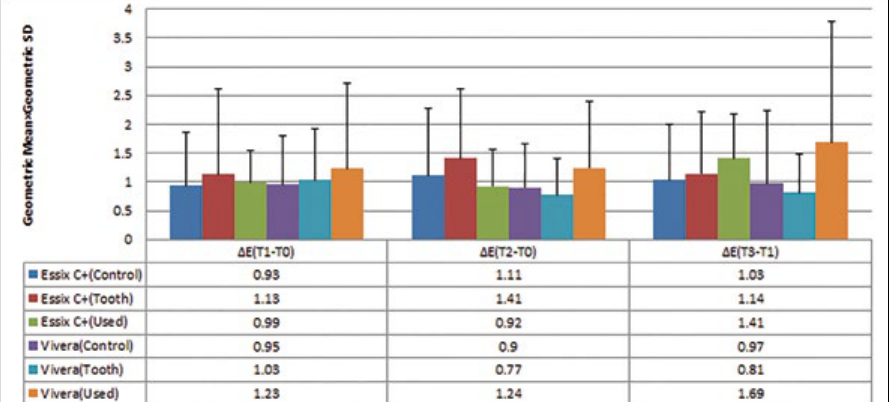
Figure 3. Geometric Mean × Geometric SD of the parameter ΔE for tooth